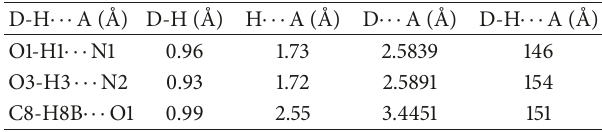
Figure 2: ESI mass spectrum for complex 2 .